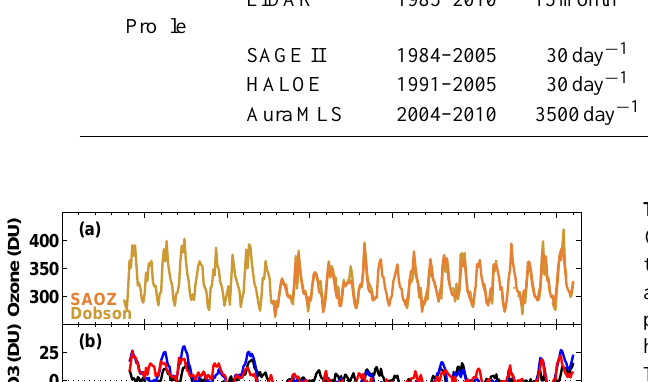
Twice the standard deviation of the regression coefficient is also